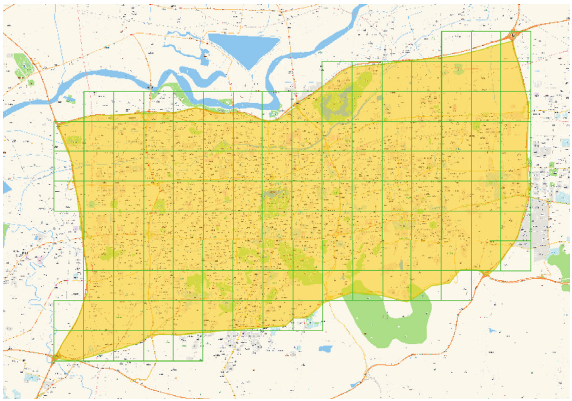
Figure 1: Study area of this